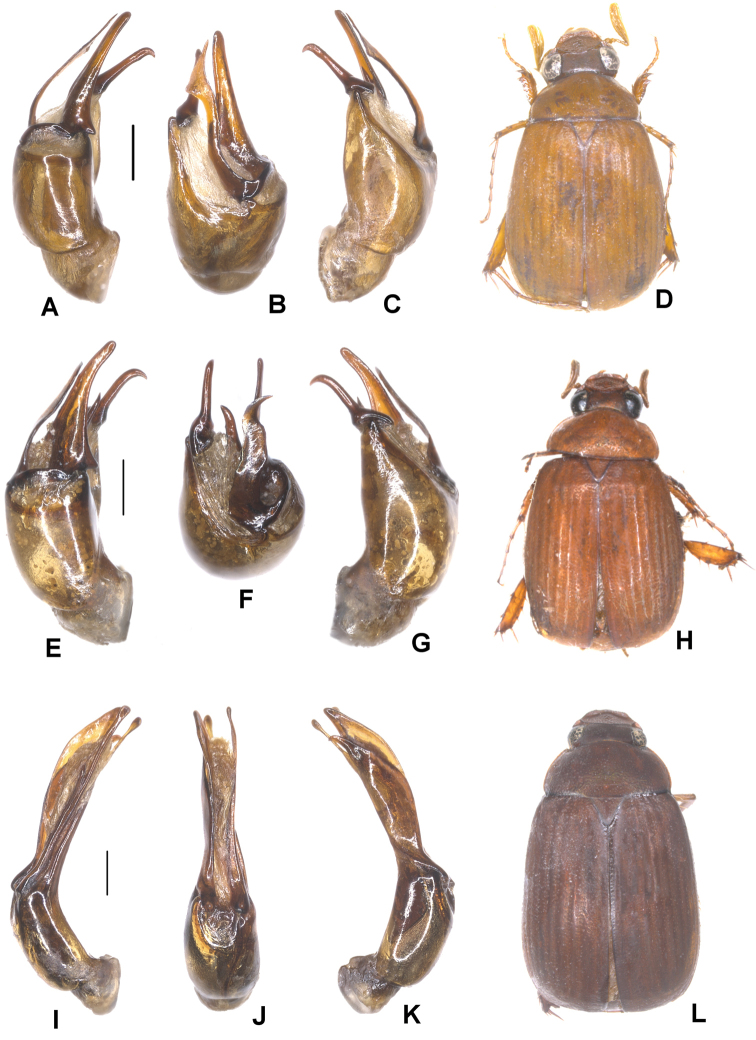
A–DTetrasericashanensis sp. n. (holotype) E–HT.semishanensis sp. n. (holotype) I–LT.sejugata (Brenske, 1898) (Myanmar, Ruby Mines) A, E, I aedeagus, left side lateral view C, G, K aedeagus, right side lateral view B, F, J parameres, dorsal view D, H, L habitus. Scale bars: 0.5 mm. Habitus not to scale.